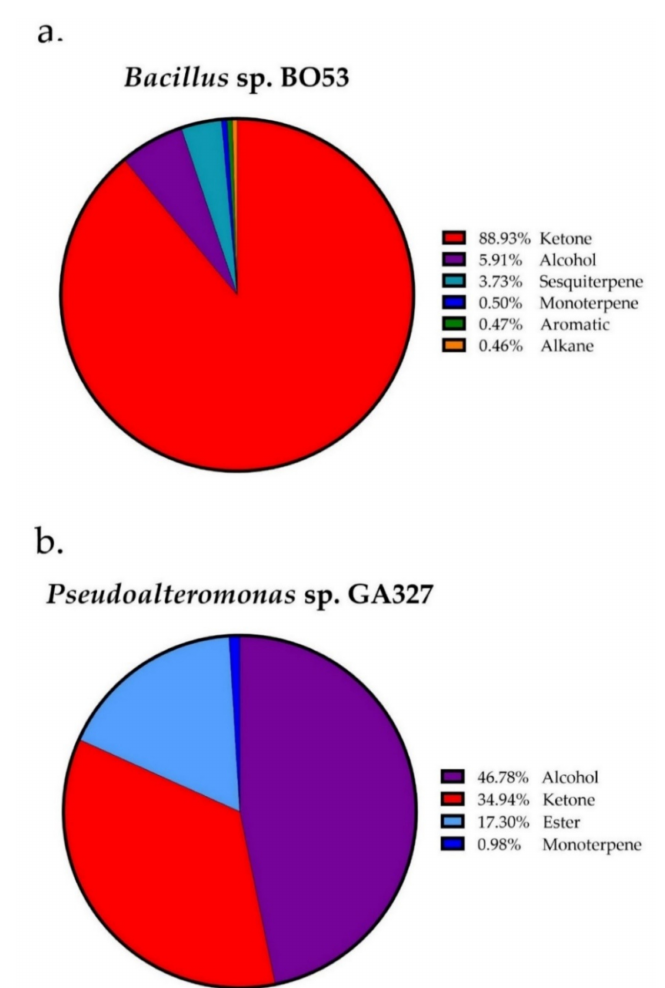
Figure 1. The proportion of the chemical families of VOCs detected in octocoral-associated bacteria Bacillus sp. BO53 and Pseudoalteromonas sp.